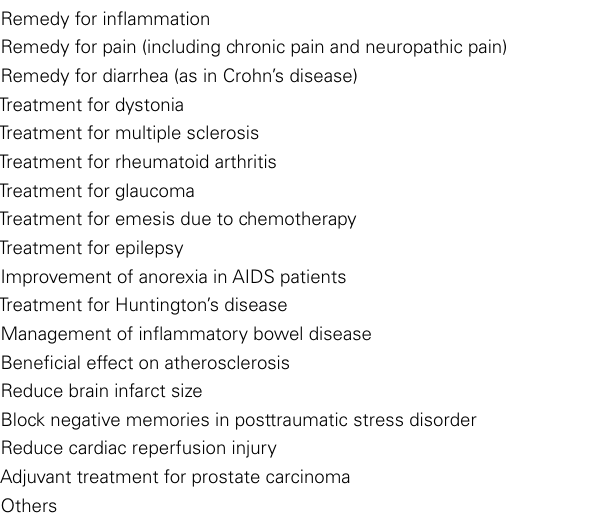
Table 3 | Potential benefits of cannabis based on research studies (see